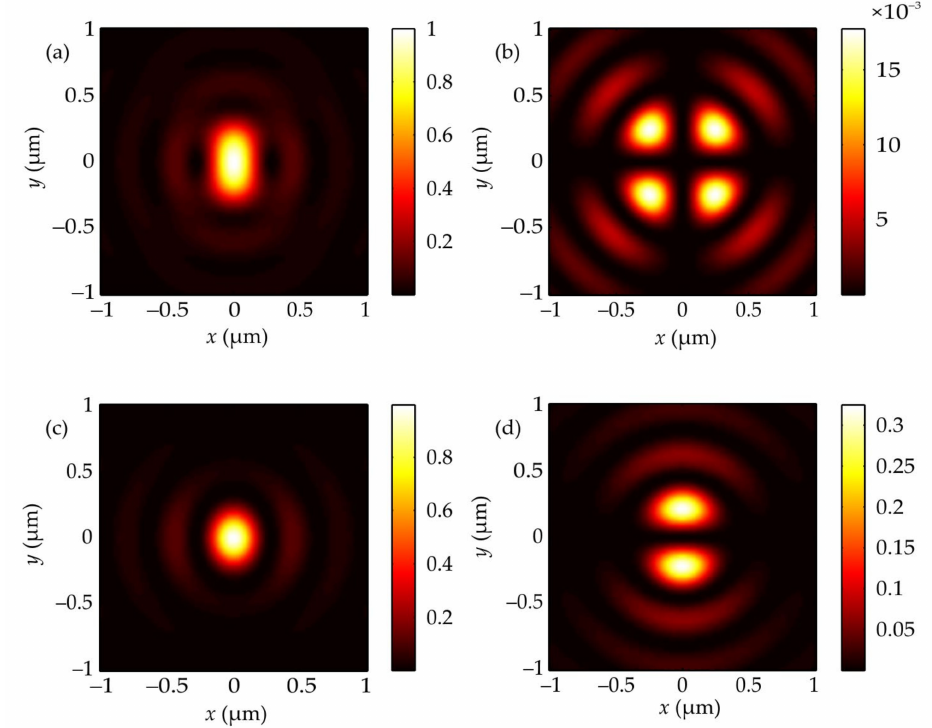
Figure 1. Distribution of the total intensity I x + I y + I z ( a ) and individual components of the intensity I x ( b ), I y ( c ), I z ( d ) in the plane of